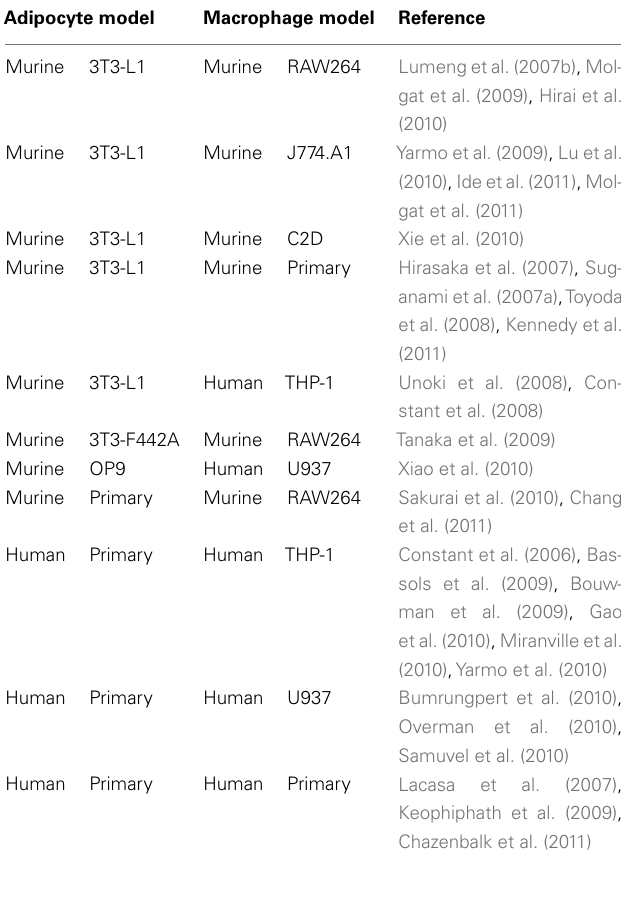
Table 1 | In vitro models (conditioned media, indirect, or direct co-cultures) for studying the inflammatory process in adipose